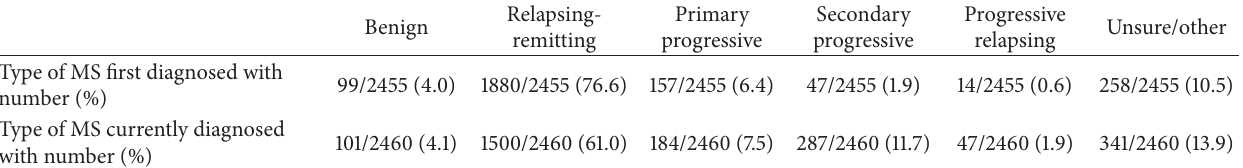
Table 5: Diagnosed subtype of MS.